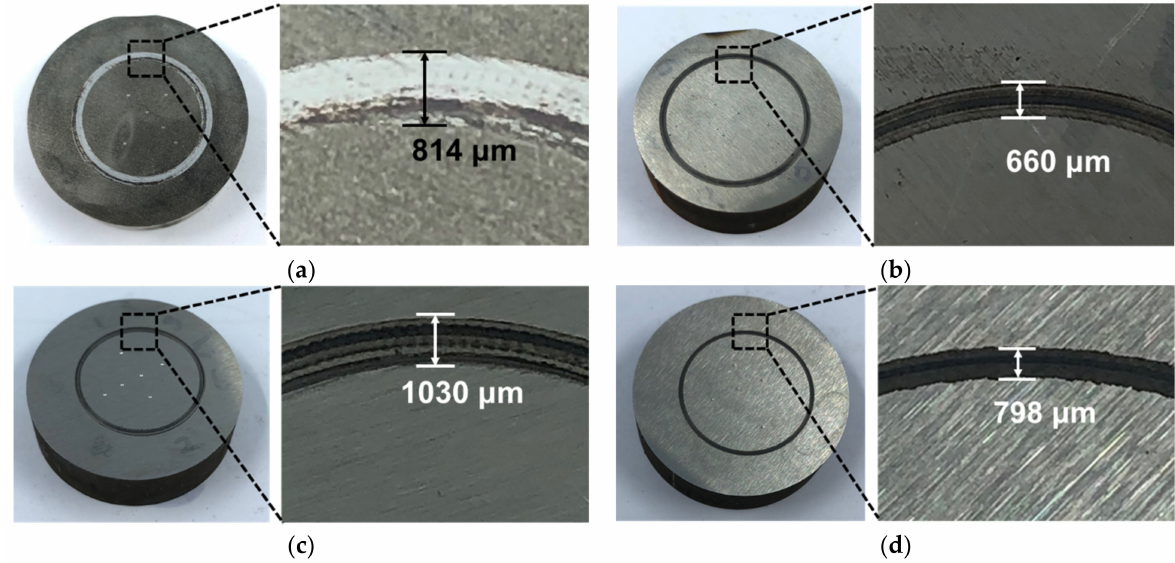
Figure 9. Images of wear scars after ball-on-disc wear test; ( a ) C-SCM420, ( b ) as-built (M2), ( c ) as-built (FeCrVMoW) and ( d ) as-built